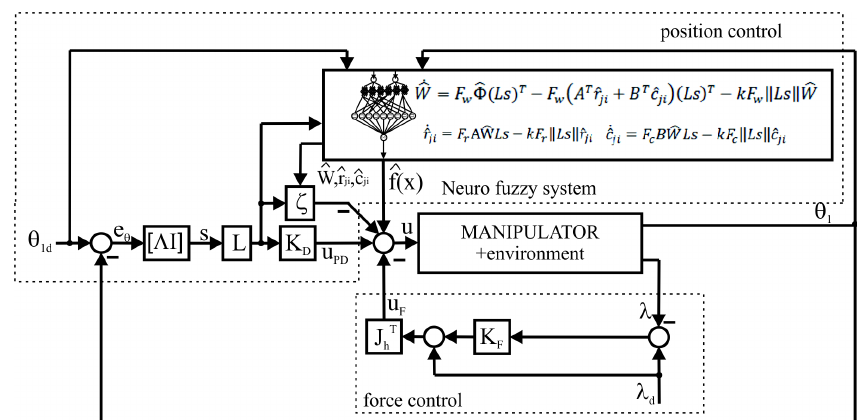
Figure 7: Schematic of the neuro-fuzzy control system for a manipulator.